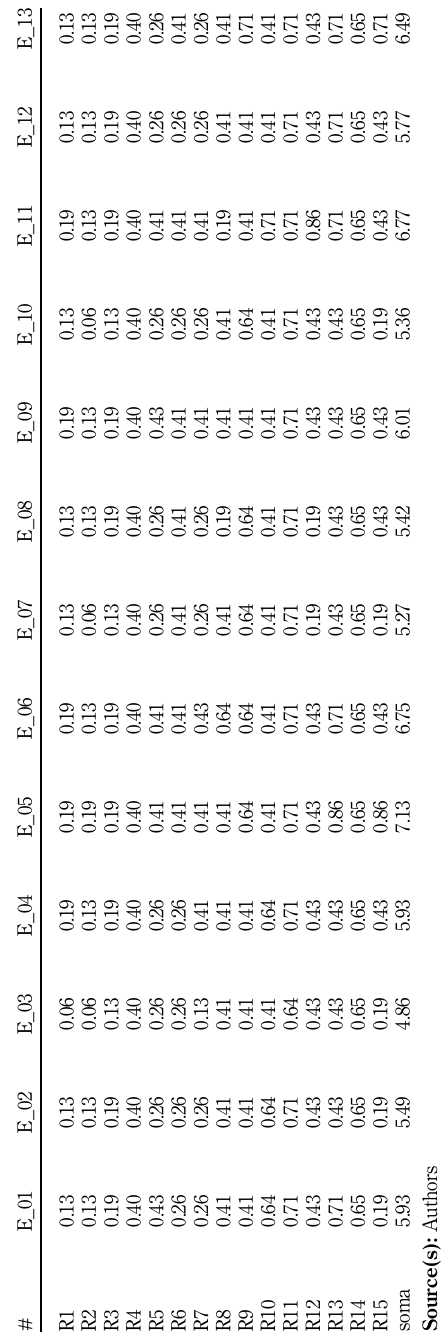
Table 5. Distances to the ideal positive solution and total distance